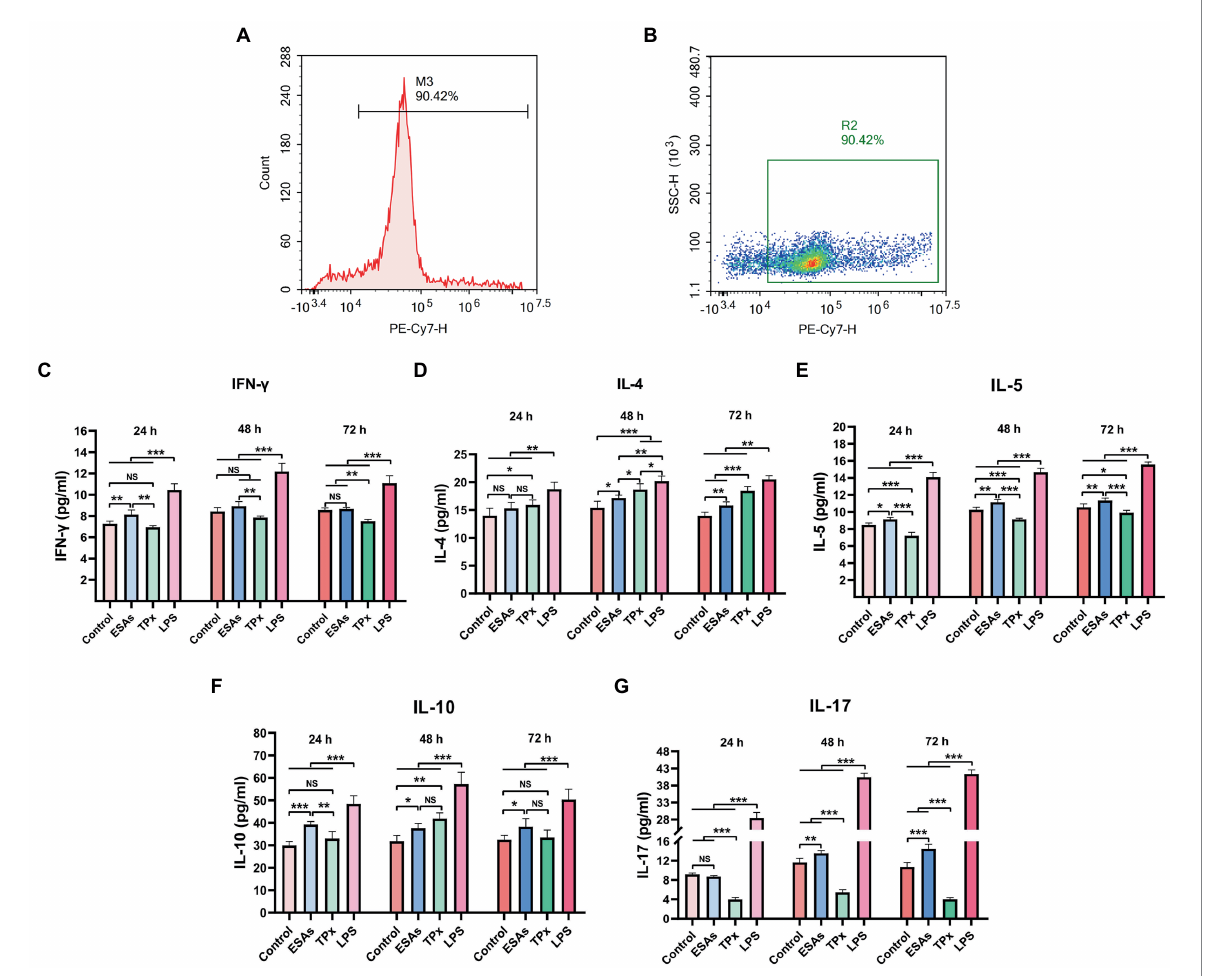
FIGURE 4 Detection of cytokines in the Th subsets. (A,B) The purity of naive CD4 + T cells was detected by flow cytometry. (C) Th1: C. cellulosae ESAs significantly promoted the secretion of interferon- γ (IFN- γ ) at 24 h, but the secretion of IFN- γ was not remarkable with the extension of the culture time. TPx did not induce the secretion of FN- γ at 24 and 48 h but inhibited the secretion of IFN- γ at 72 h. (D,E) Th2: The secretion of IL-4 by C. cellulosae ESAs was not obvious at 24 h. With the prolongation of the culture time, the level of IL-4 secretion increased significantly, and the secretion of IL-5 was promoted at 24, 48, and 72 h. TPx promoted the secretion of IL-4 but inhibited secretion of IL-5 at 24, 48, and 72 h. (F) Th2/ Treg: C. cellulosae ESAs promoted the secretion of IL-10 at 24, 48, and 72 h. However, the level of secreted IL-10 induced by TPx did not increase significantly at 24 h, but significantly increased at 48 h. (G) Th17: C. cellulosae ESAs did not induce a significant increase in IL-17 level at 24 h. With the prolongation of culture time, the secretion of IL-17 was significantly increased, while TPx inhibited the secretion of IL-17 at 24, 48, and 72 h. All data were represented by means ± SD; NS stands for not significant, * p < 0.05, ** p < 0.01, *** p <